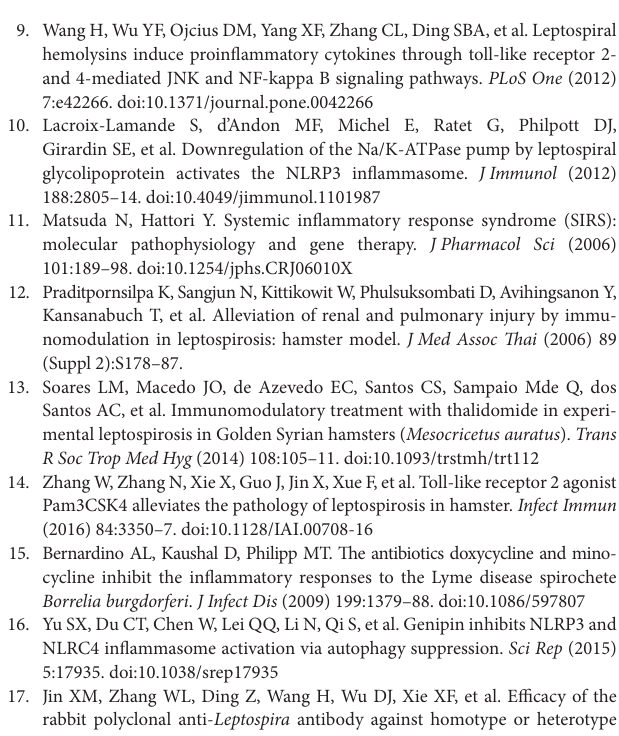
FigUre s1 | Effect of doxycycline on the cell viability of J774A.1 cells. Cells were cultured with different concentrations of doxycycline (0–20 µg/ml) for 24 and 48 h. The cell viability was determined by CCK-8 kit. Bars show the mean ± SD of three independent